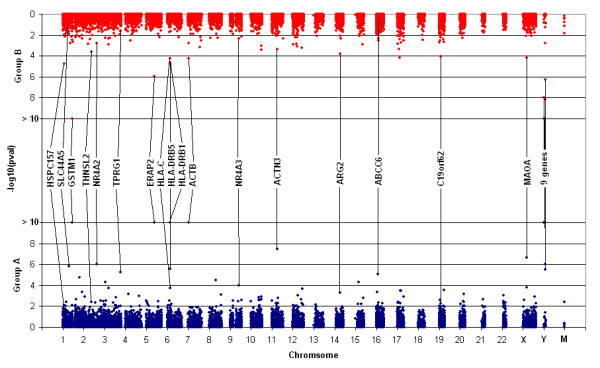
Two-way Manhattan plot of significance for bimodality in both of the independent groups. Shown are the -log10 p-values for bimodality for each of the 17,881 genes from trimmed Group A (blue circles, n = 65) and from trimmed Group B (red circles, n = 43). Genes with a combined Fisher's FDR < 0.05 are labeled (see Additional files 3 and 4).